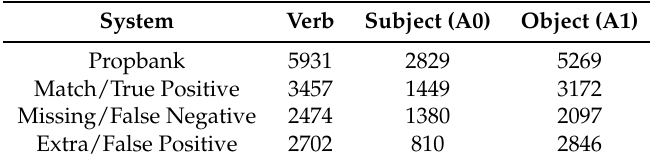
Table 9. Linguakit evaluation on Data set 1.